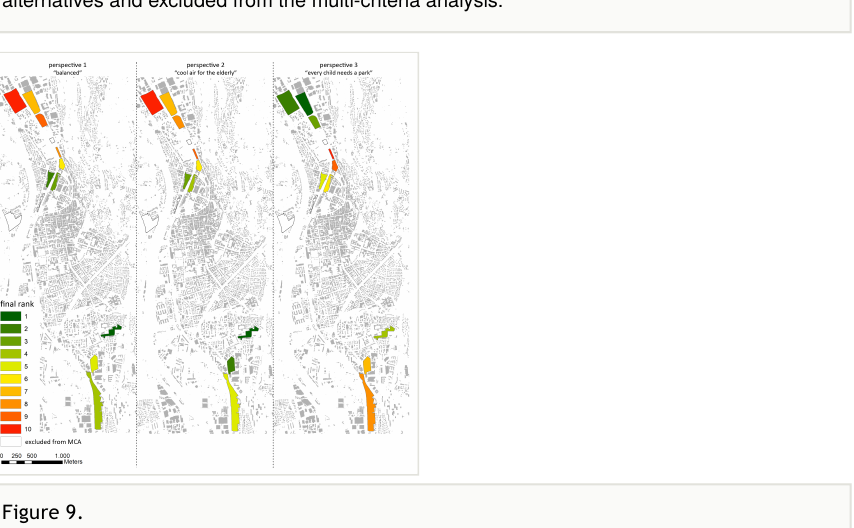
Overall, the three illustrative perspectives show how priorities for brown fi eld regeneration change based on the relative importance attributed to the di ff erent ES and the respective categories of bene fi ciaries (Fig. 9). To assess the stability of the ranking and the robustness of the results with respect to possible variations in the assigned weights, we conducted a sensitivity analysis. Considering the weights assigned to the main criteria, i.e. the two ES, the rakings produced by perspective 1 ('balanced') and 2 ('cool air for the